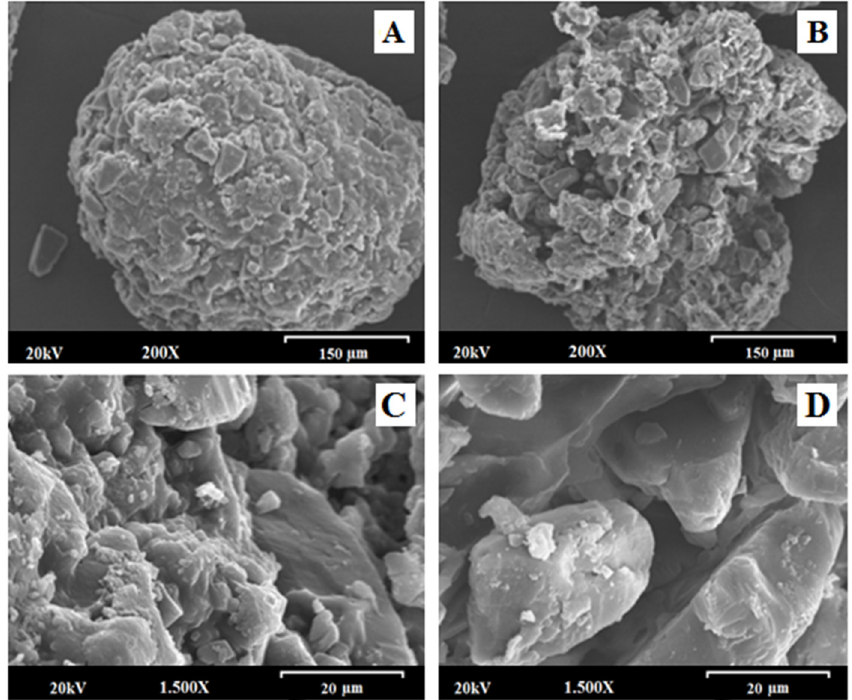
Figure 7. Scanning electron micrographs of CNM multiparticulate system and its blank formulation at a magnification of 200× and the scale bar is equal to 150 µm: ( A ) CNM multiparticulate system; ( B ) blank CNM formulation; Scanning electron micrographs of CNM multiparticulate system and its blank formulation at a magnification of 1500× and the scale bar is equal to 20 µm:( C ) CNM formulation and ( D ) blank CNM formulation.